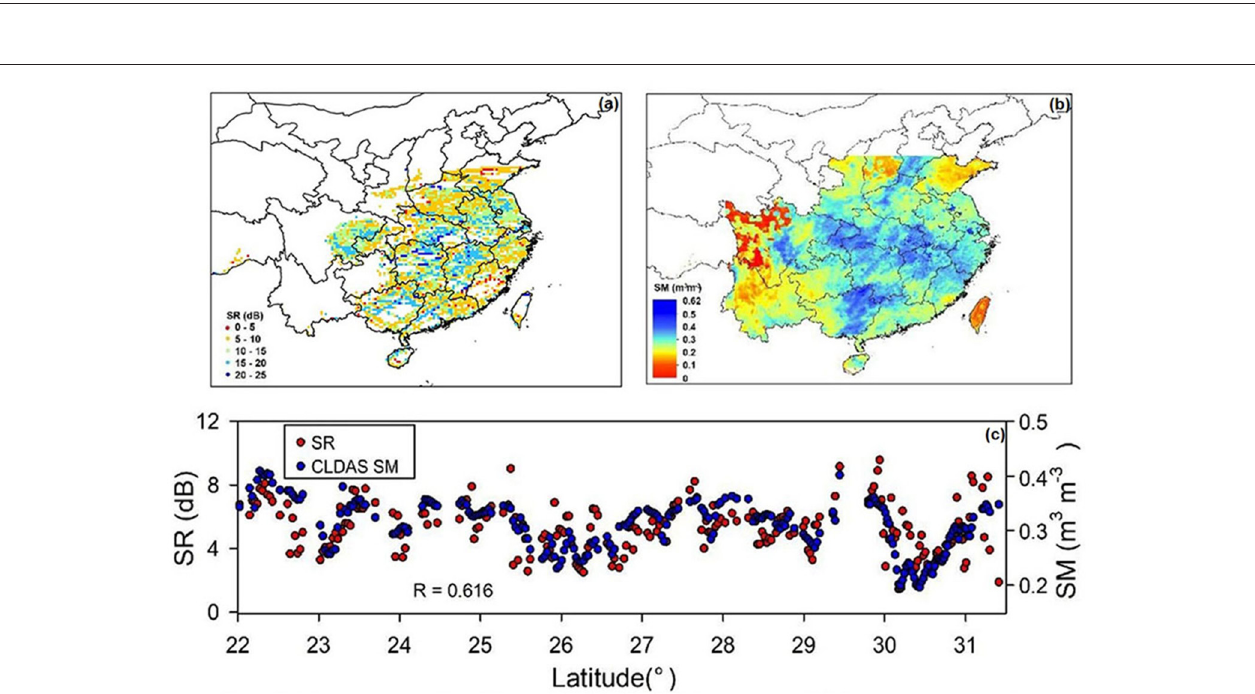
FIGURE 3 | (a) Distribution of CYGNSS SR on April 21, 2018, (b) Distribution of CLDAS SM on April 21, 2018, and (c) Comparisons of the SR derived from CYGNSS against CLDAS SM for locations with latitudes between 22 ◦ to 31.5 ◦ .